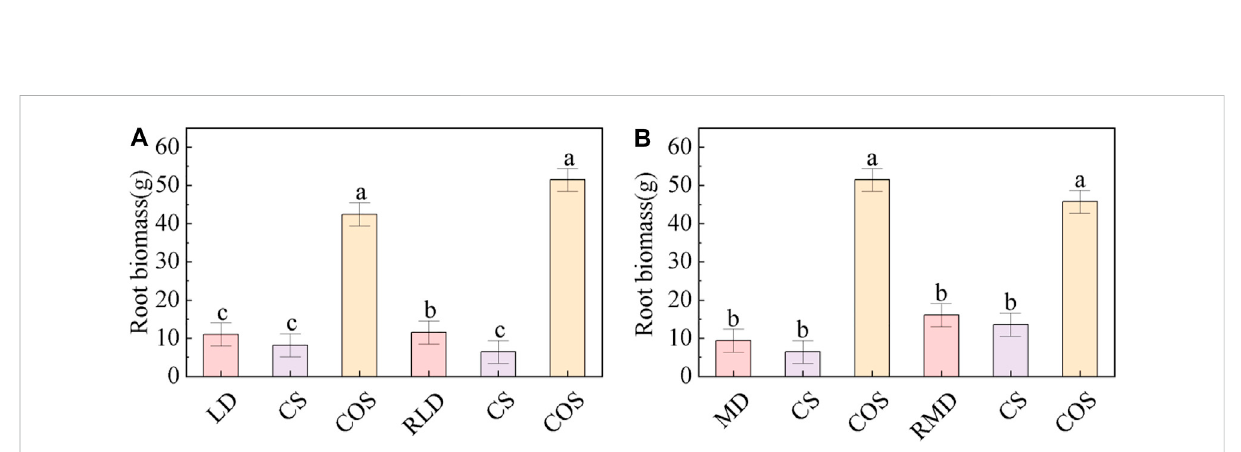
FIGURE 8 Comparison of root biomass of summer maize under different drought and drought rehydration conditions. (A) is the root biomass under LD andRLD, (B) istherootbiomassunderMDand RMD.Differentsmalllettersinthe fi gure indicatethatthedifferencebetween treatmentsissigni fi cant ( p <